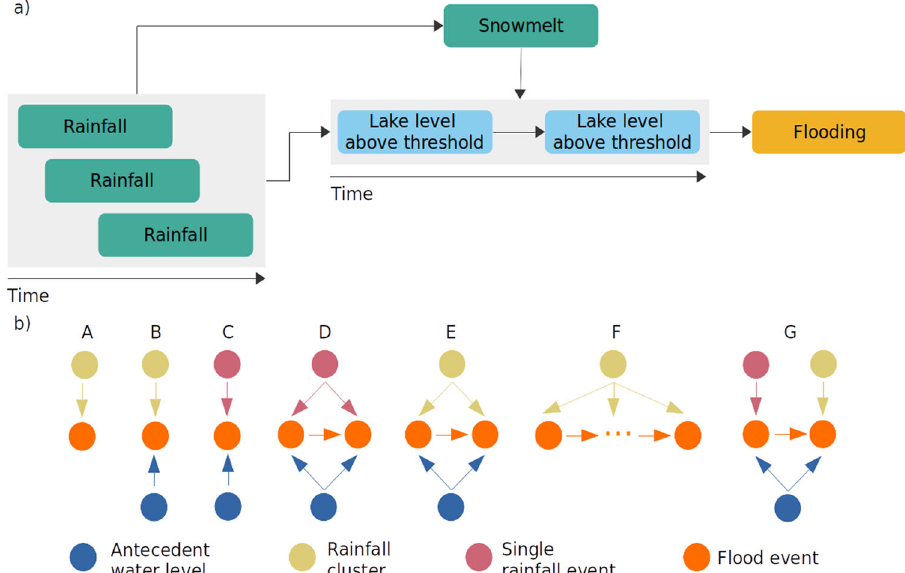
Fig. 3 Connections and variables in lake fl oods. a Path diagram of a lake fl ood event, climate-based; b seven (referred respectively as A, .., G) different modes of lake fl oods climate-based, obtained with different combinations of drivers and